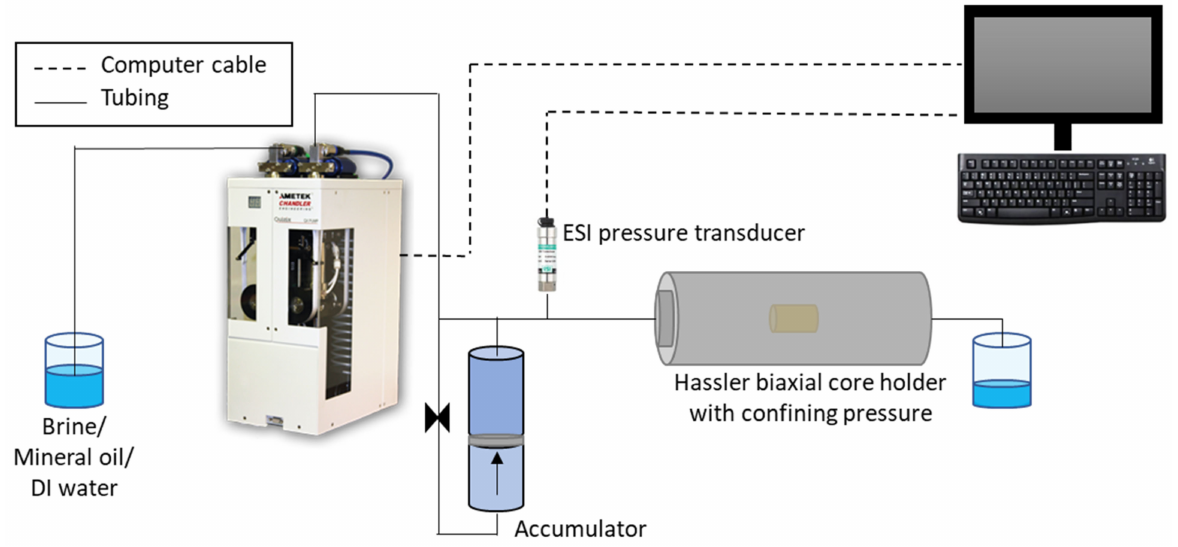
Figure A2. Schematic of the experimental setup used for forced imbibition and drainage. Forced fluid injections were performed at ambient